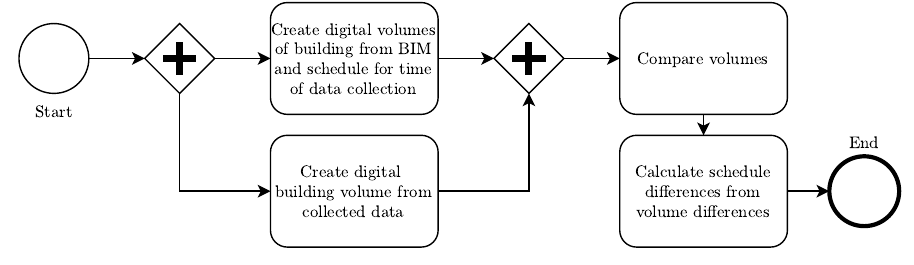
Figure 6. Progress monitoring